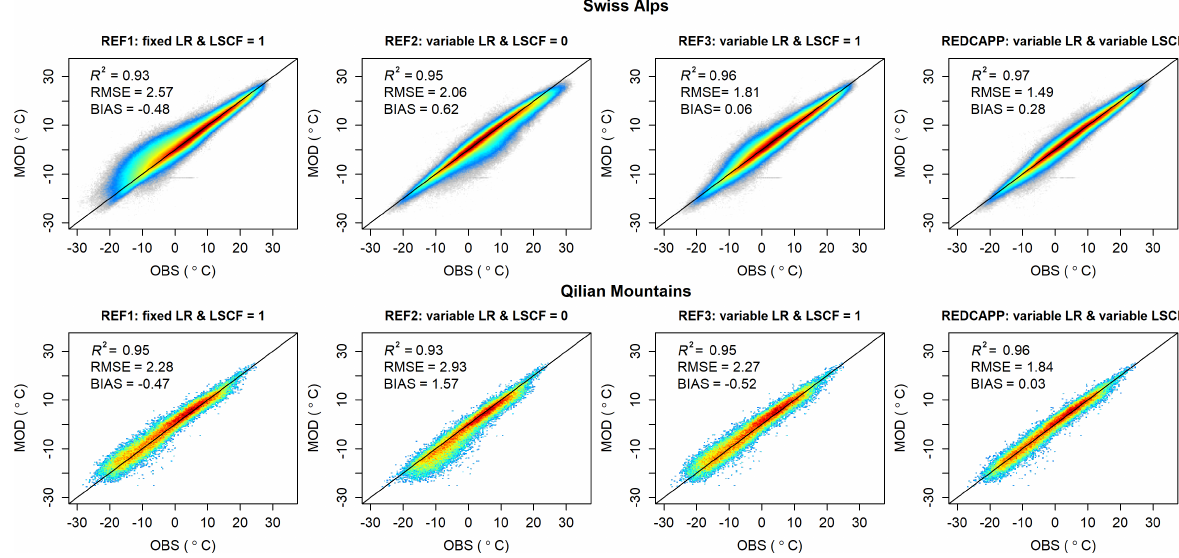
Figure 10. T obs (OBS) against results of REF1, REF2, REF3 and REDCAPP (MOD). LR in the subtitles indicates lapse rate.